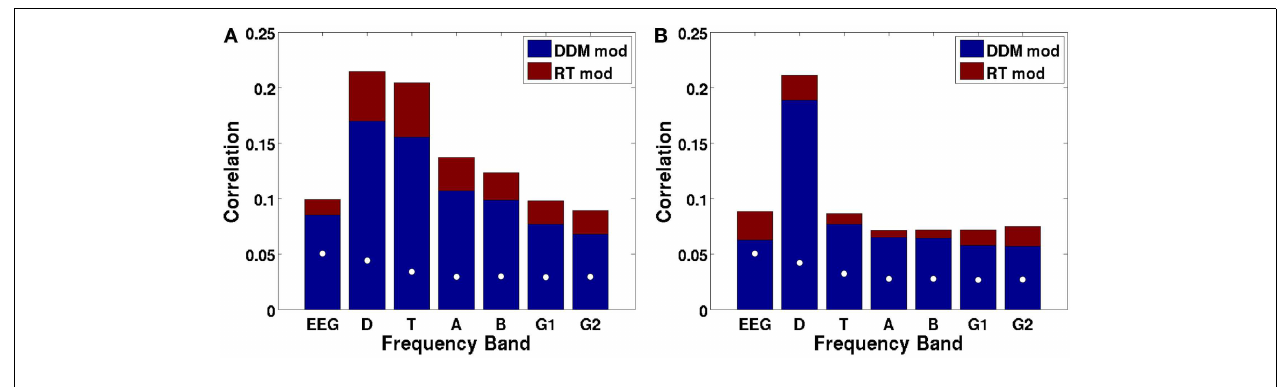
percentile of the distribution of canonical correlations expected based on random regressors. Letters indicate frequency bands: EEG = raw EEG, D = 2–4Hz delta,T = 4–9Hz theta, A = 9–14Hz alpha, B = 14–28Hz beta, G1 = 28–48Hz low gamma, and G2 = 48–90Hz high